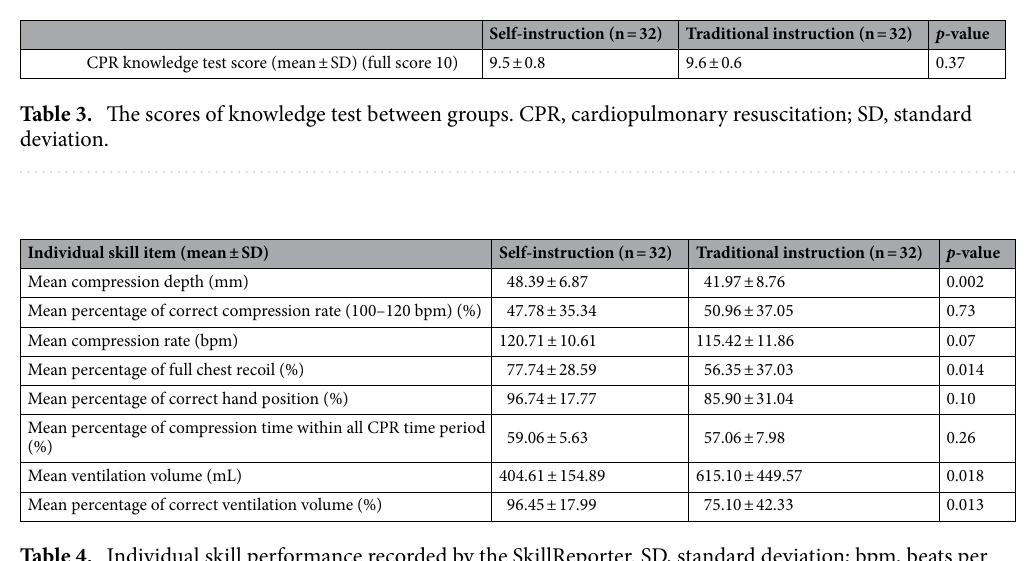
Table 4. Individual skill performance recorded by the SkillReporter. SD, standard deviation; bpm, beats per minute; CPR, cardiopulmonary resuscitation.